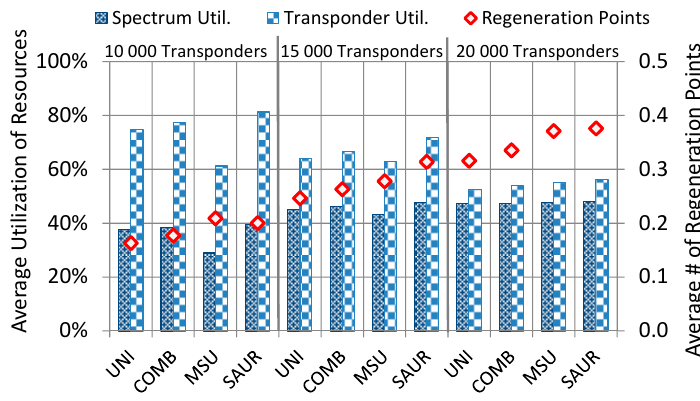
Spectrum Util. Transponder Util.